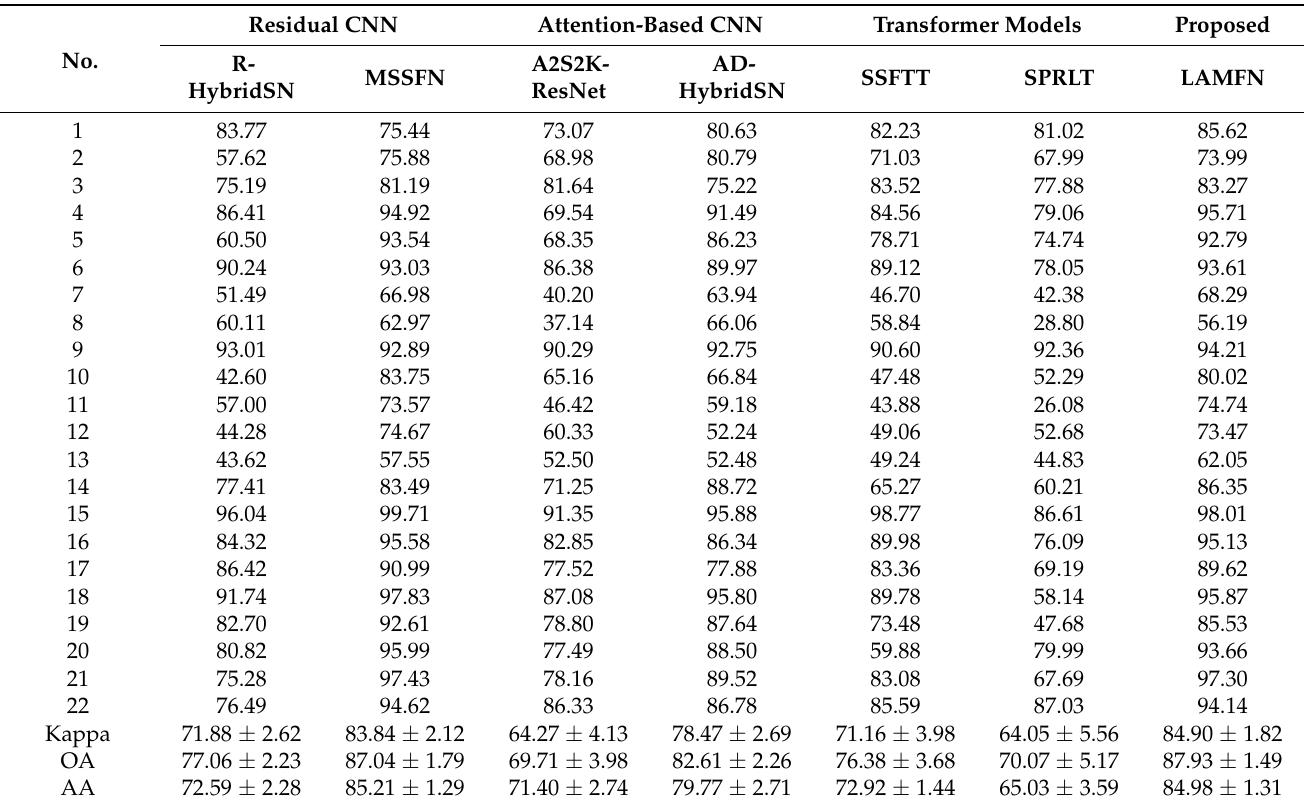
Table 6. Classification results of different models in WHU